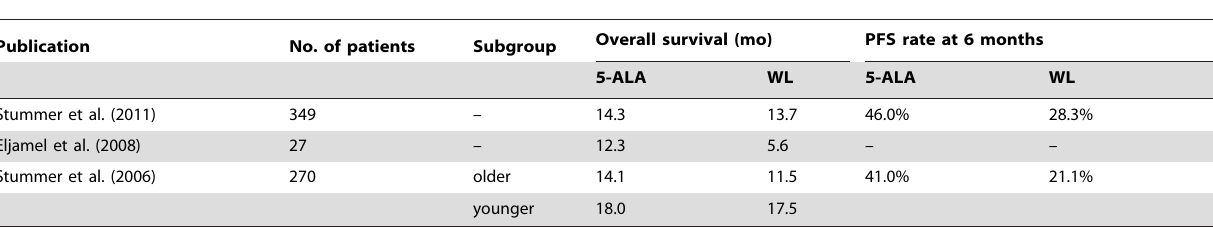
Table 6. Survival